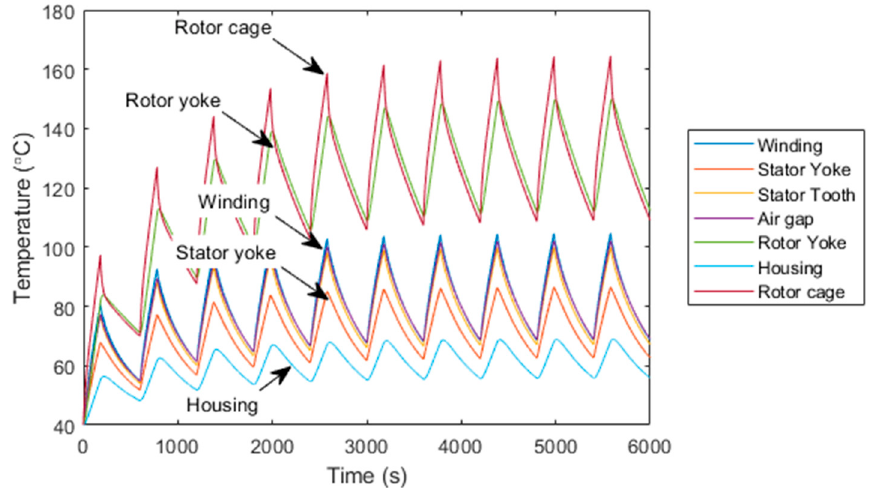
Figure 8. Thermal simulation for S3 30% duty cycle.